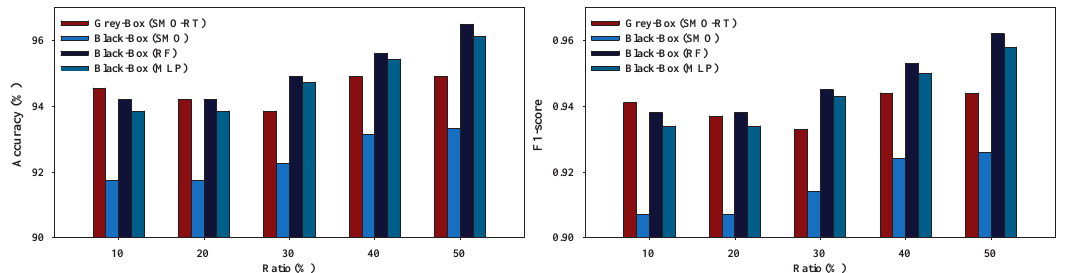
Figure 14. Box-plot with performance evaluation of Grey-Box and Black-Box models for Winsconsin